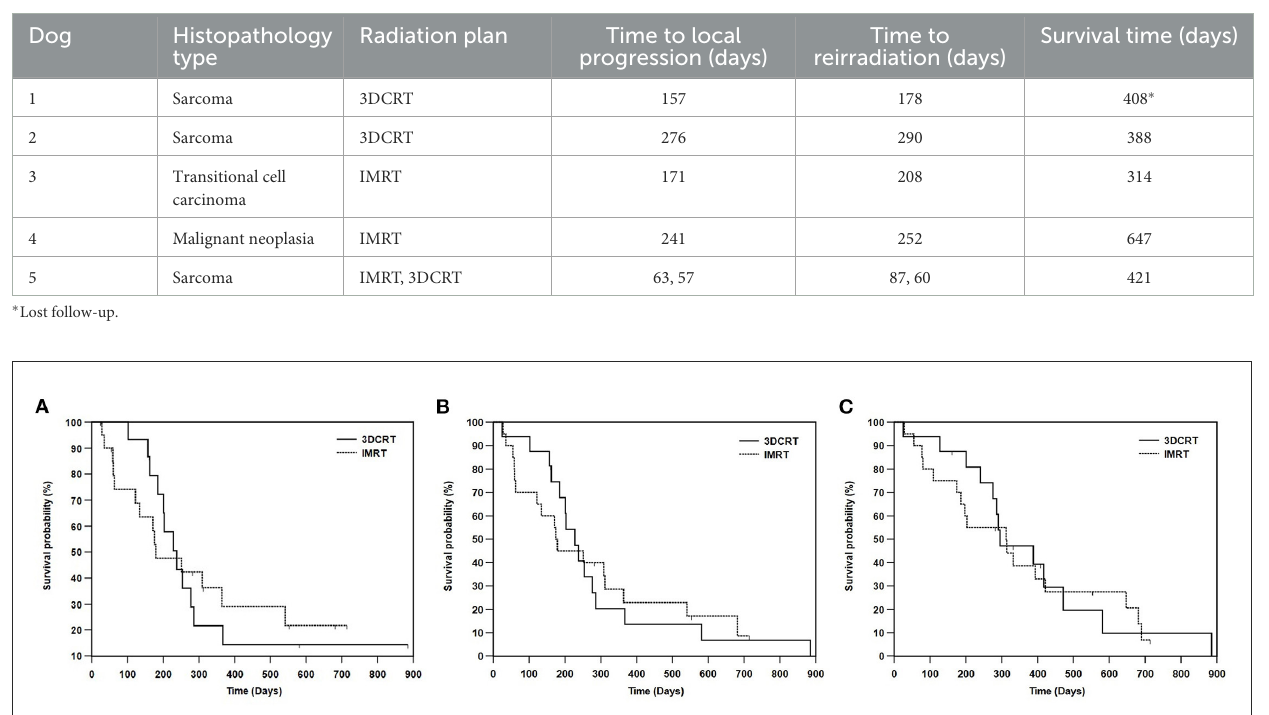
FIGURE1 Kaplan-Meier survival curves showing (A) TTLP, (B) PFS, and (C) OS between the dogs treated with 3DCRT or IMRT. The median TTLP for dogs treated with 3DCRT or IMRT was 238 days and 179 days, respectively ( p = 0.967). The median PFS for dogs treated with 3DCRT or IMRT was 228 and 175 days, respectively ( p = 0.940). The median OS for 3DCRT or IMRT was 295 days and 312 days, respectively ( p = 0.787). No significant differences were seen in TTLP, PFS and OS between the 3DCRT and IMRT groups. TTLP, time to local progression; PFS, progression-free survival; OS, overall survival; 3DCRT, 3-D conformal radiation therapy; IMRT, intensity-modulated radiation